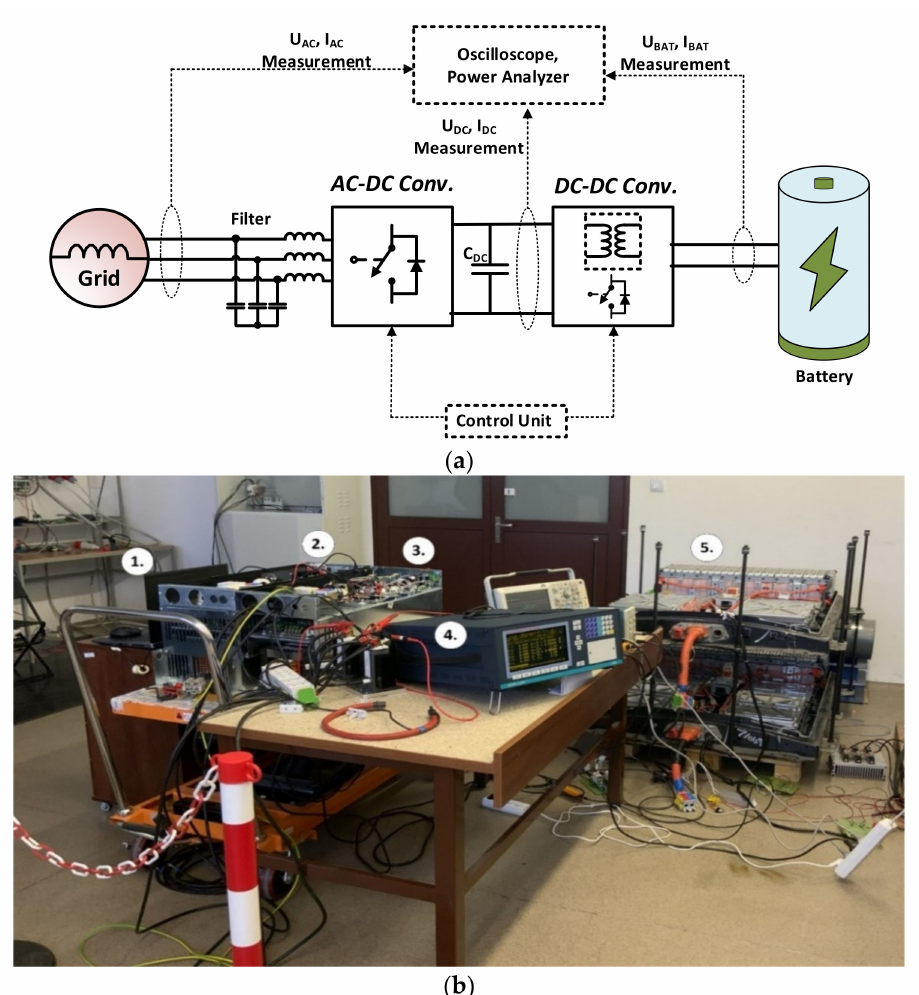
Figure 12. Experimental test bench used during the research: ( a ) block scheme; ( b ) view of the test bench: 1.—control platform; 2.—50 kW unidirectional charger made in IGBT technology composed of 2-level AC/DC and SAB converters; 3.—50 kW bidirectional charger made in SiC technology